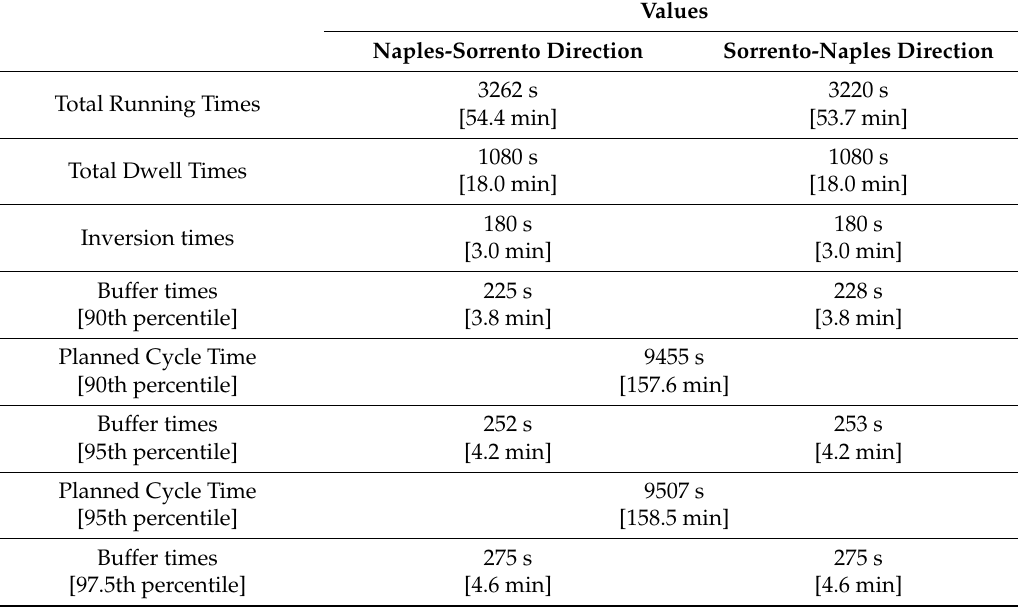
Table 1. Main operational parameters of the regional ‘Naples-Sorrento’ rail line.